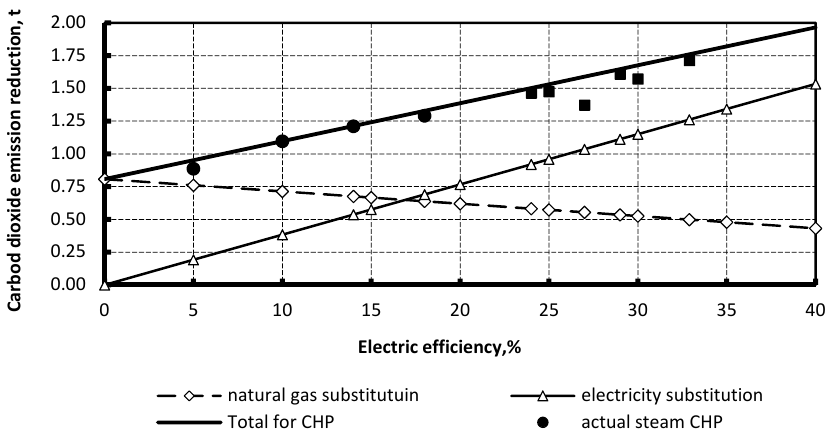
Figure 7. Carbon dioxide emission reduction potential per one ton of husk.